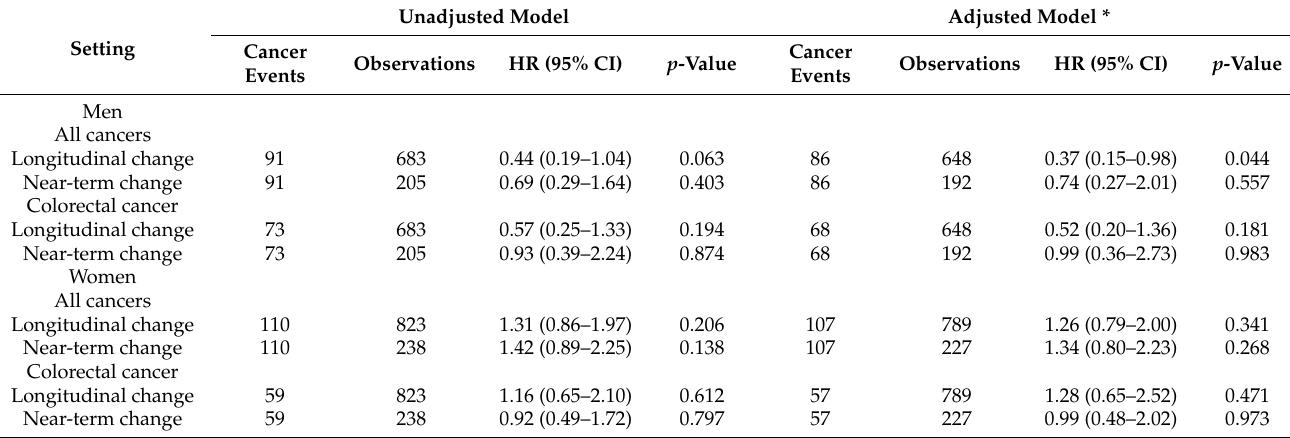
Table 6. Hazard ratios for associations of physical activity and cancer risk in participants with Lynch